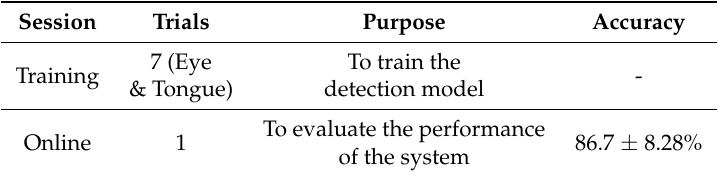
Table 6. Phases of experiment in